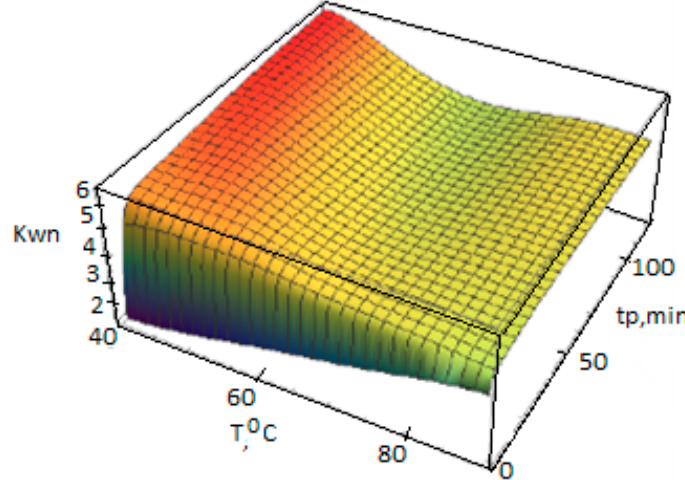
Figure 6. Dependence of the polydispersity coefficient of PP on the temperature T and the polymer- ization duration t p , calculated according to the polycenteric model using the activation energies from Table 3 (polymerization conditions in Table 2).